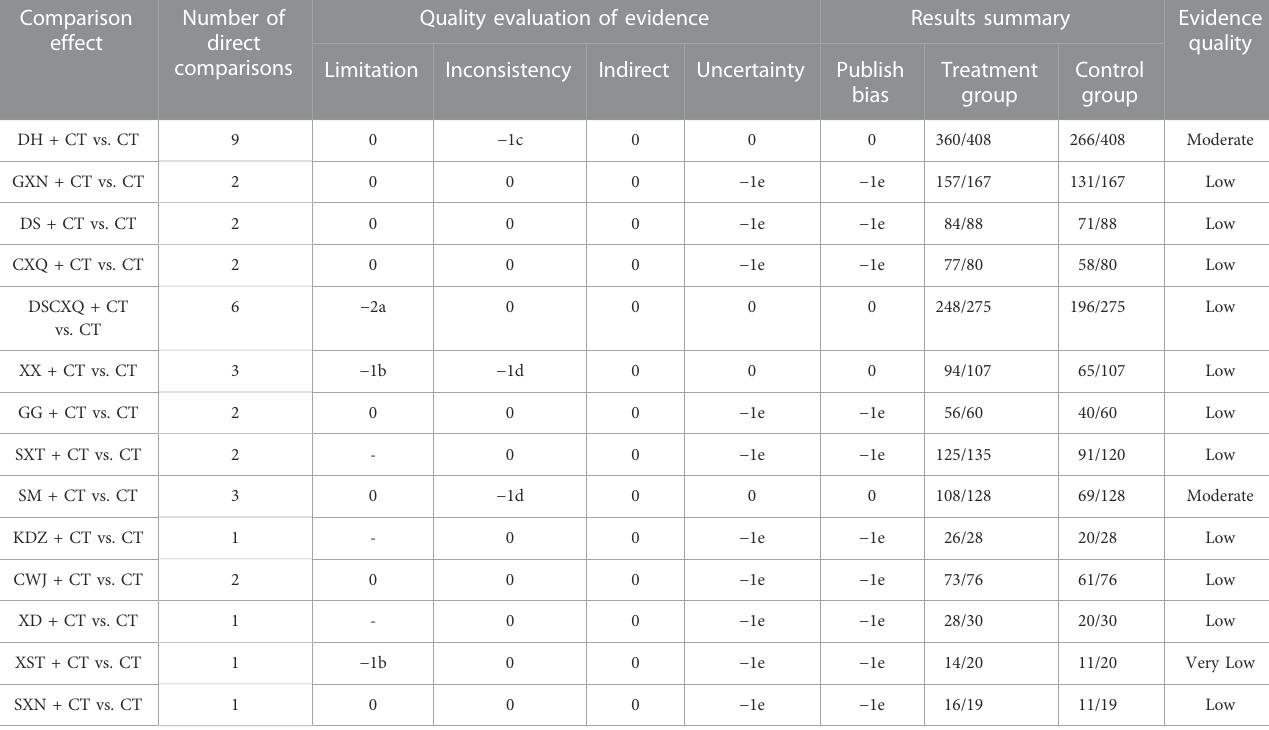
TABLE 3 GRADE assessment for the total effective rate.